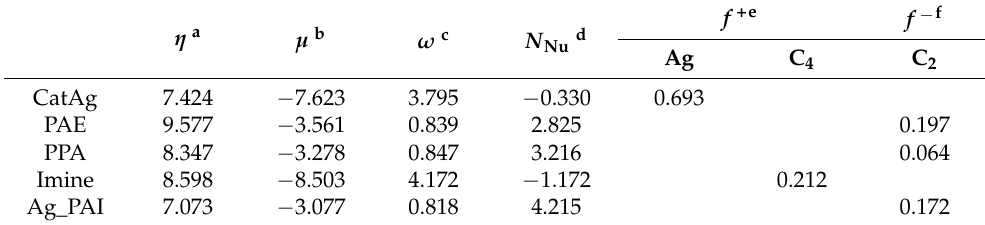
Table 6. GRI and Fukui function data for certain molecules.